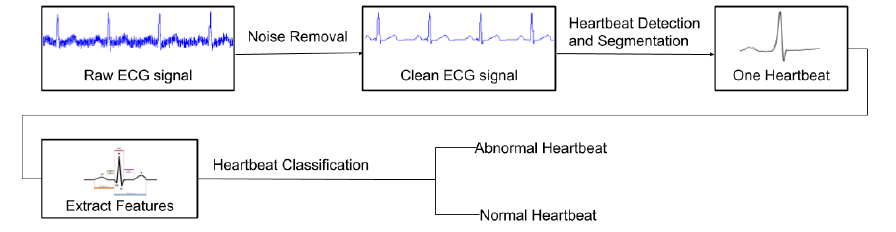
Figure 9. Typical Heartbeat Anomaly